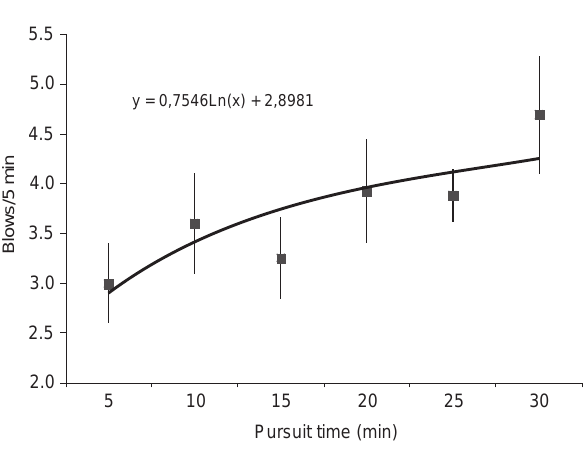
Figure 1. Respiratory frequency of the humpback whales during pursuit and respective tendency line and logarithmic equation, showing a significant gradual increase.